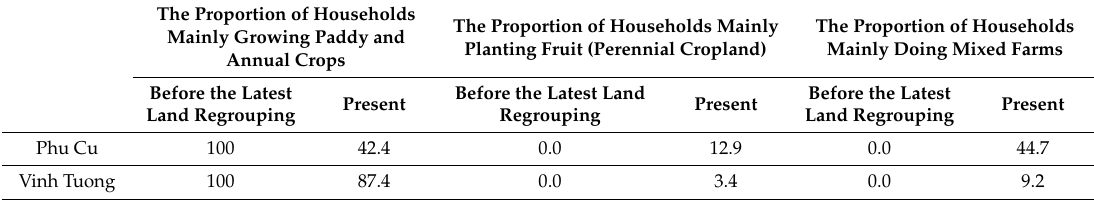
Table 7. The proportion of households by agricultural land use structure.